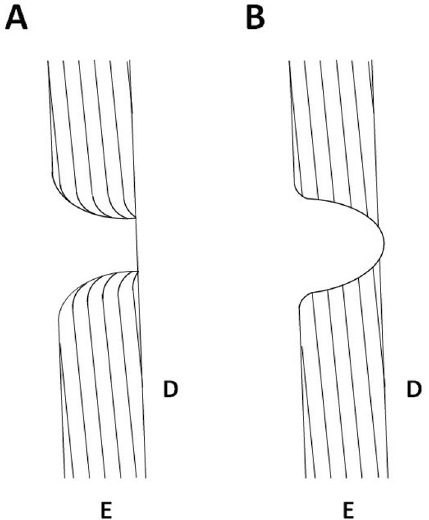
Figure 4. Schematic diagram of two longitudinal histological sections showing the differences between ( A ) a pit-form hypoplastic defect and ( B ) a pit produced by other processes such as flaking of poorly mineralized enamel or enamel erosion due to mechanical wear. ( A ) In a pit-form hypoplastic defect the rim of the pit is smoothly curved and the striae of Retzius in the enamel forming the walls of the pit are also curved. ( B ) A pit produced by flaking of poorly mineralized enamel or enamel erosion due to mechanical wear cross-cuts normal striae of Retzius and it usually lacks a smooth and curved rim. E = enamel; D = dentine; lines in enamel represent striae of